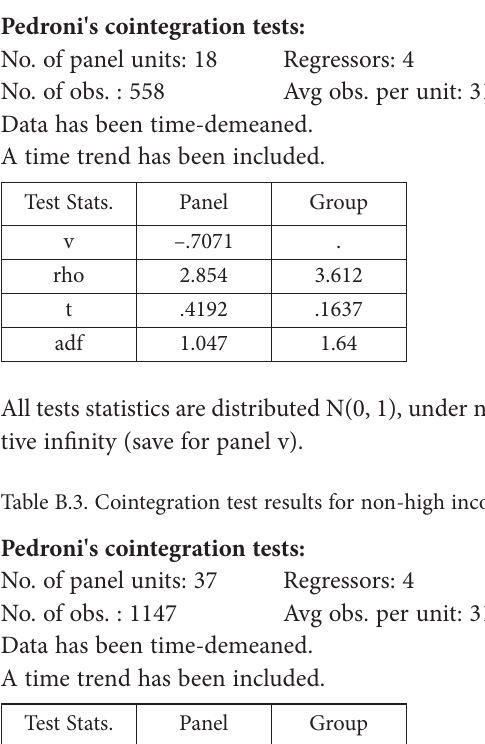
Table B.2. Cointegration test results for high income countries sample